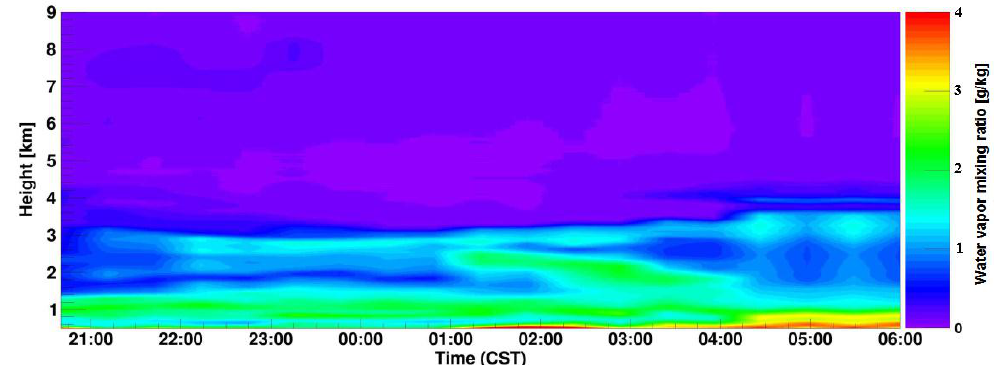
Figure 4. THI plot of water vapor mixing ratio profiles during 20:30–06:00 LST on 16 November 2016.